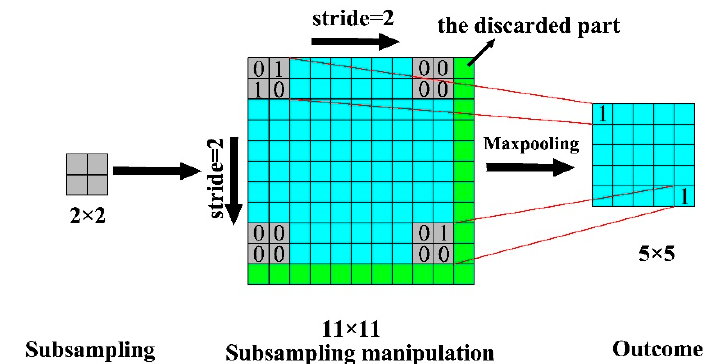
Figure 9. The subsampling manipulation (VALID padding).